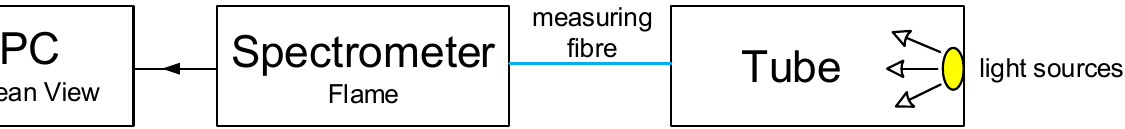
Figure 2. The setup to measure spectra characteristics of the tested light sources.